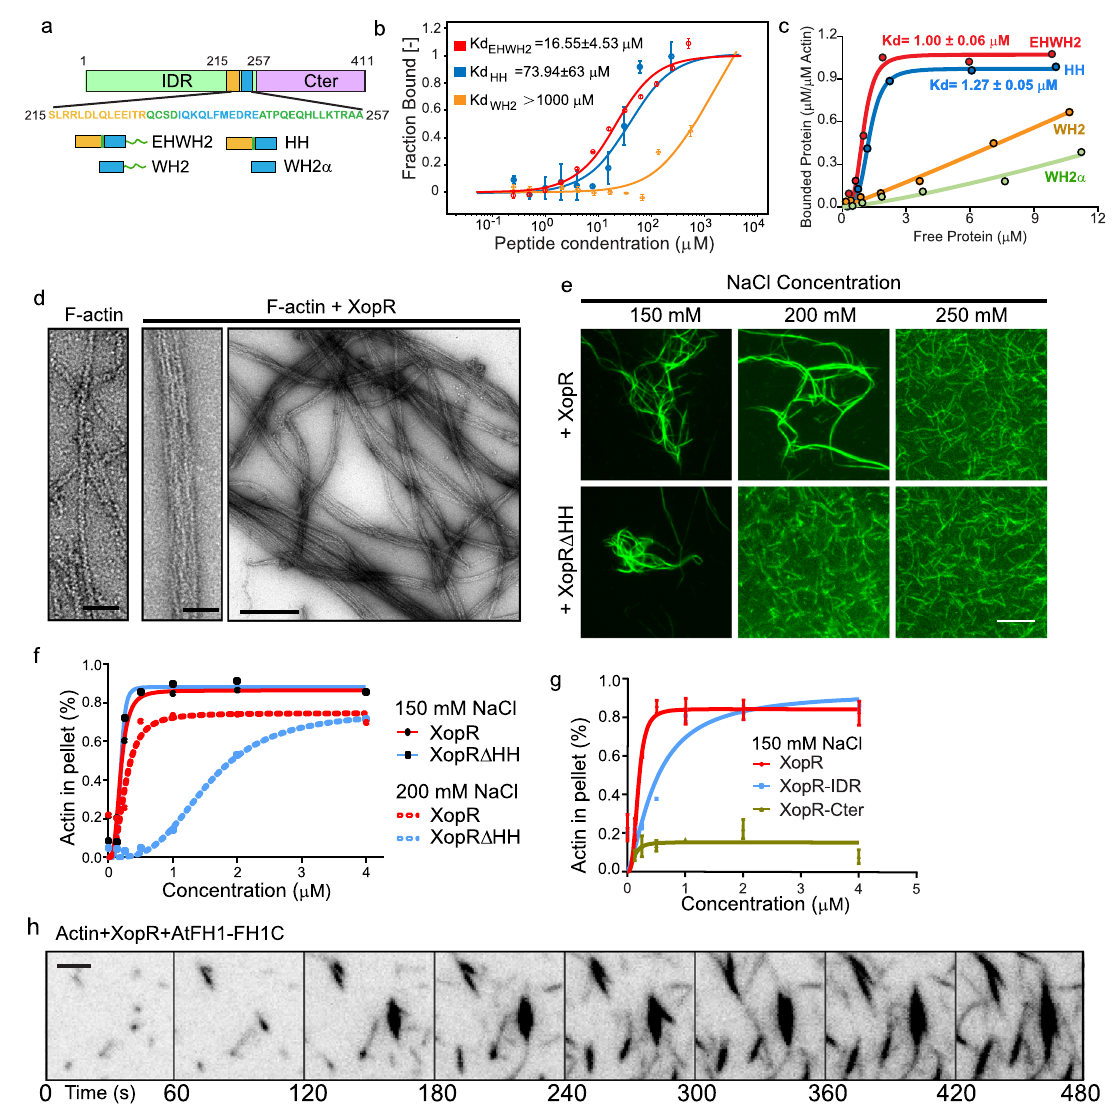
Fig. 5 Binding and bundling of F-actin by XopR. a Schematic domain illustration of four XopR truncation variants, EHWH2, HH, WH2, and WH2 α . b MST binding curves of LatB-G-actin titrated with different XopR peptides with three biological replicates each. n = 3; Error bar, SD. c High-speed F-actin cosedimentation assay using MBP-EHWH2-msfGFP, MBP-HH-msfGFP, MBP-WH2-msfGFP, and MBP-WH2 α -msfGFP. The data were fi t using a Hill equation. d Negative stain electron microscopy (EM) of F-actin bundles formed by mixing 1 μ M XopR with 0.2 μ M F-actin in 150 mM NaCl. Scale bar from left to right: 400, 50, and 50 nm. e Micrographs of 0.2 μ M F-actin in the presence of 10 μ M XopR and XopR Δ HH in the indicated NaCl buffer. F-actin was labeled with Acti-stain ™ phalloidin. Scale bar = 5 μ m. f Low-speed F-actin cosedimentation assay with XopR and XopR Δ HH in the buffer with both 150 and 200 mM NaCl. g Low-speed cosedimentation assay of XopR full-length, XopR-IDR and XopR-Cter in 150 mM NaCl solution ( n = 3 biological replicates). Data were presented as mean values± SD. The data were fi t using a Hill equation. h Representative time-lapse images of TIRF-actin polymerization over 480 s with 0.5 μ M G-actin (10% Oregon-actin), 100 nM AtFH1-FH1C, and 400 nM XopR under 50 mM NaCl conditions. Scale bar = 2 μ m for f